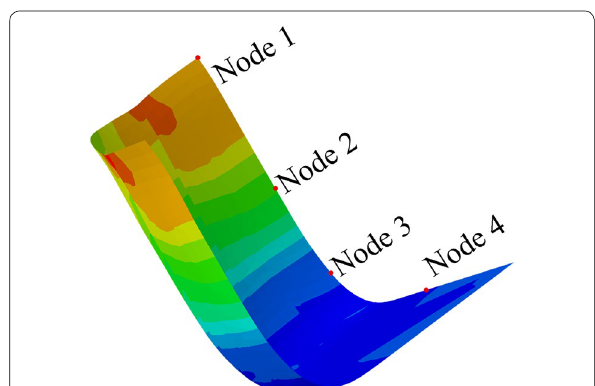
Table 5 Deep drawing process parameters (mm) Blank diameter Figure 3 Schematic diagram of deep drawing